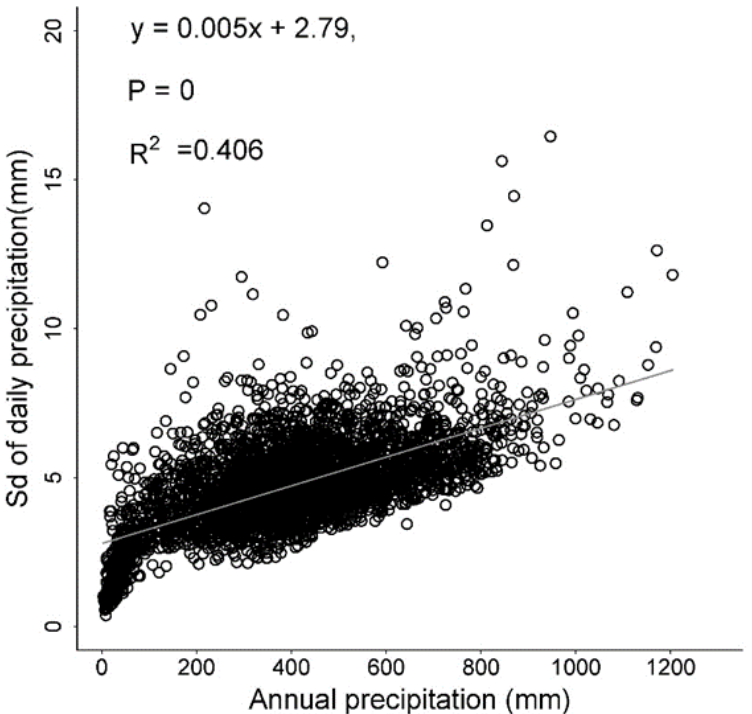
Figure A1. The relationship between annual precipitation and standard deviation (Sd) of daily precipitation in a year based on yearly data of 78 meteorological stations from 1960 to 2015 on the QTP.